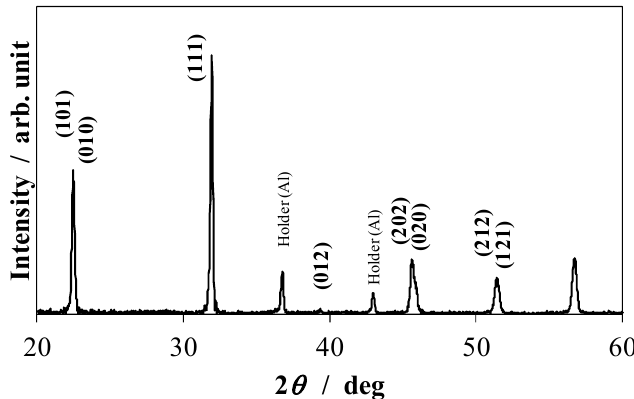
Figure 1. X ‐ ray diffraction profile of KNN ‐ CZ ‐ 2 powder calcined at 900 °C. Figure 1. X-ray diffraction profile of KNN-CZ-2 powder calcined at 900 ˝ C.